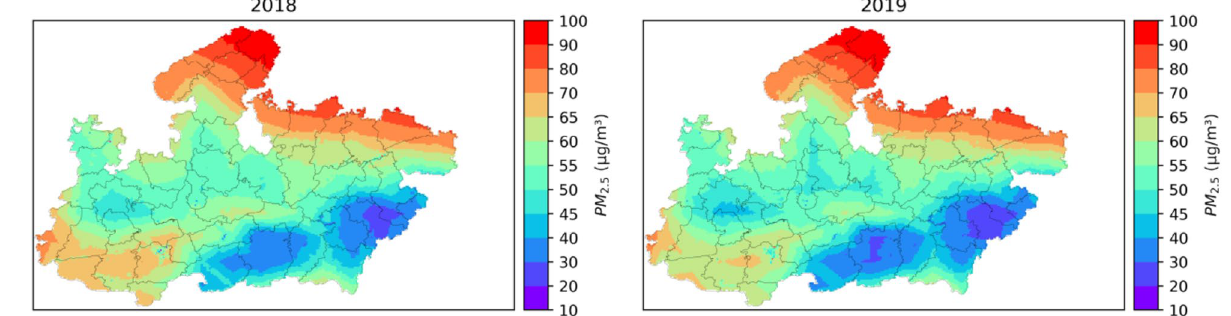
Figure 4. Spatial distribution of annual mean of daily surface PM 2.5 over Madhya Pradesh for 2018 and 2019. The figure was generated using Python (version 3.7, https ://www.pytho n.org/).